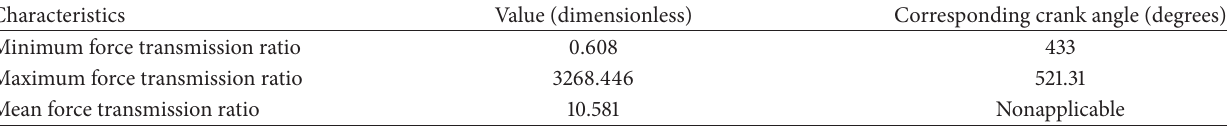
Table 4: Force transmission characteristics of the single toggle jaw